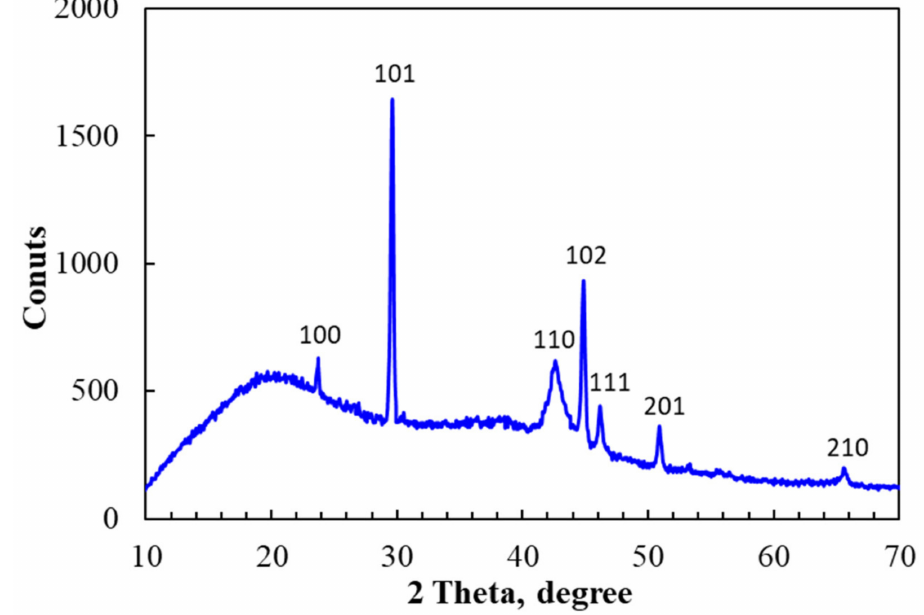
Figure 7. XRD pattern of SeNPs/ β -glucan synthesized by gamma irradiation at a dose of 8 kGy and dose rate of 10